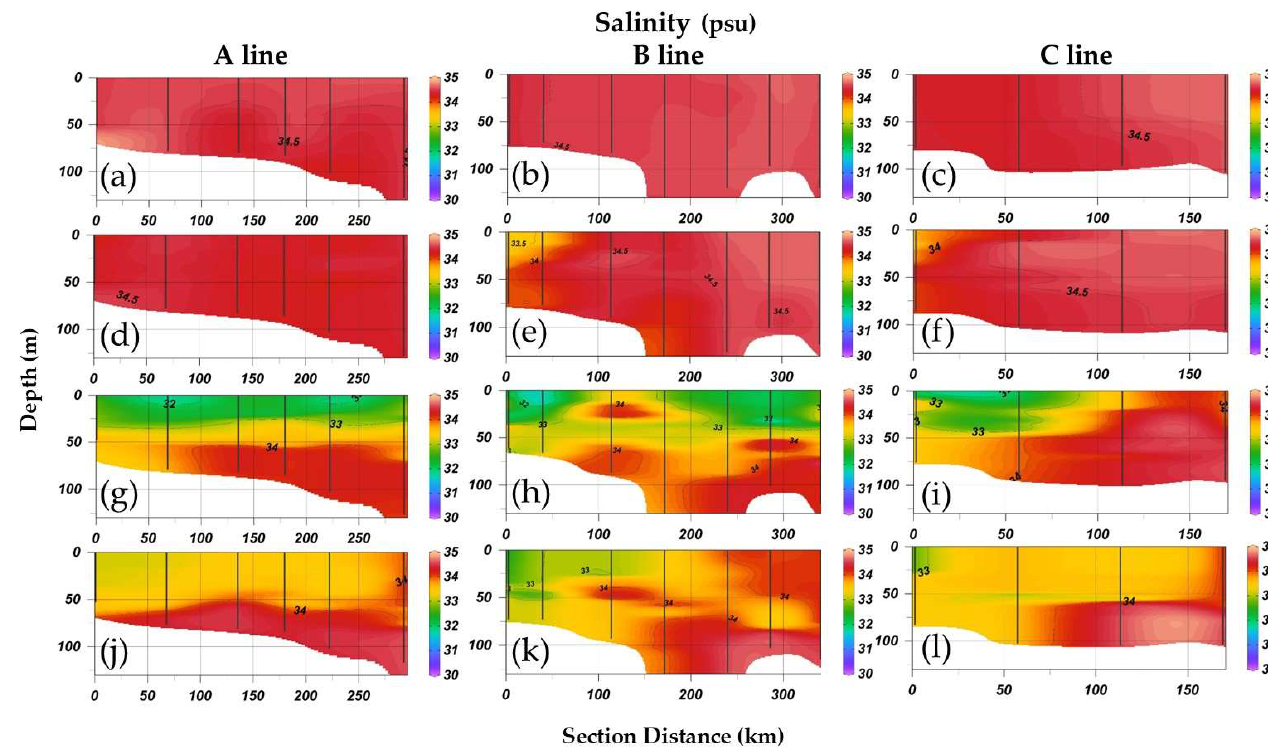
Figure 3. Vertical distribution of salinity (psu) in ( a – c ) February, ( d – f ) April, ( g – i ) August, and ( j – l ) October 2018. Lines A, B, and C represent north-to-south sampling lines in the study area.